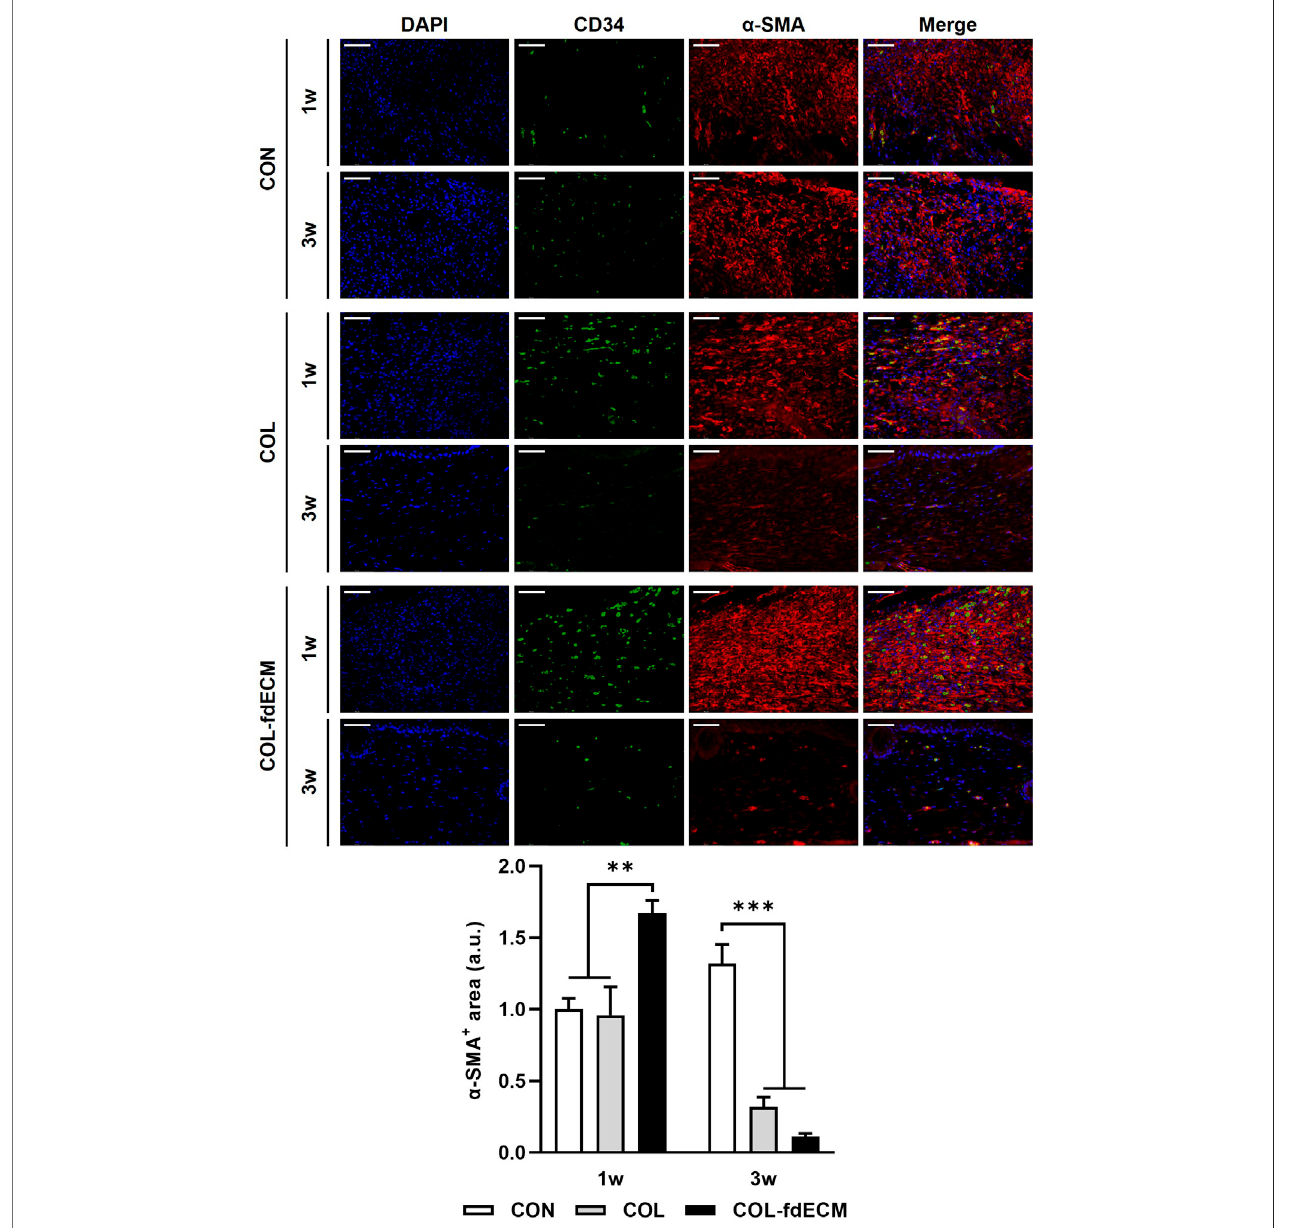
FIGURE 4 | Time-varying phenotype change of dermal fi broblasts in full-thickness skin wound after fdECM treatment. Immuno fl uorescence image and semi- quantitative analysis of dermal fi broblast stained with CD34 (green) and α -SMA (red) on tissue sections. Scale bar represents 50 μ m. Bar represents mean ± standard error of mean (SEM). ** p < 0.01, *** p <